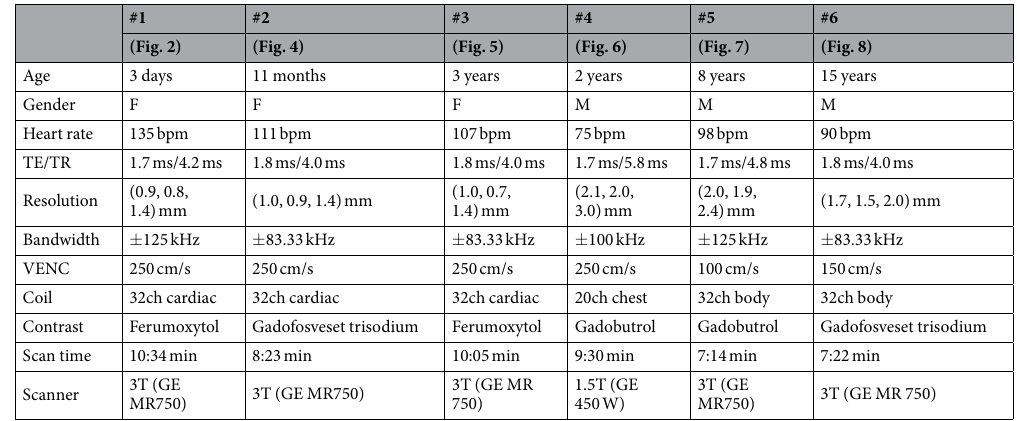
Table 1. Summary of scan